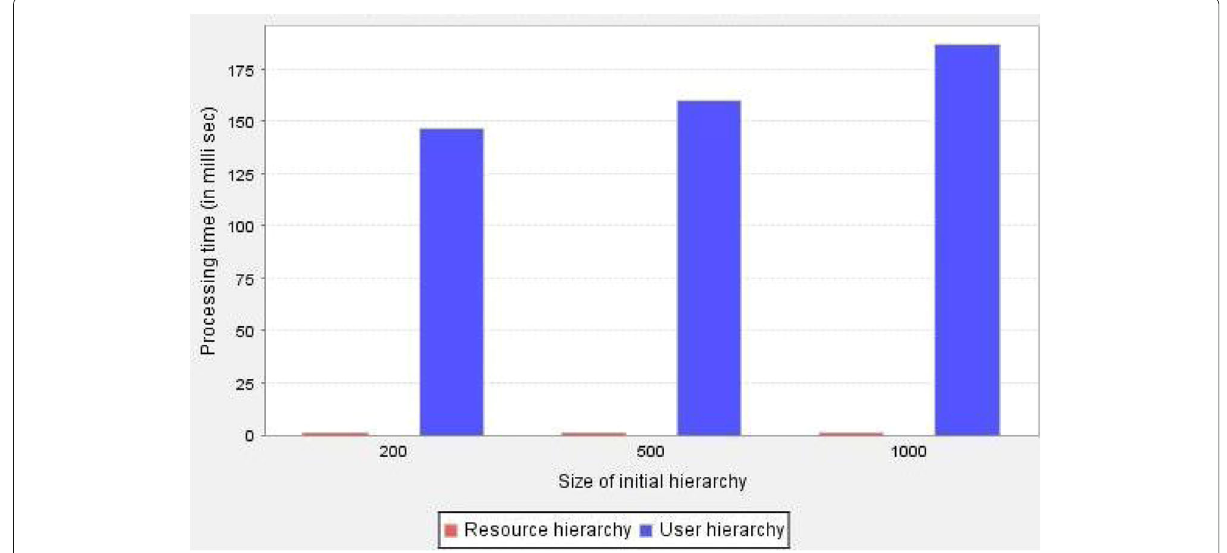
Fig. 16 Elapsed time of one grant read subscription